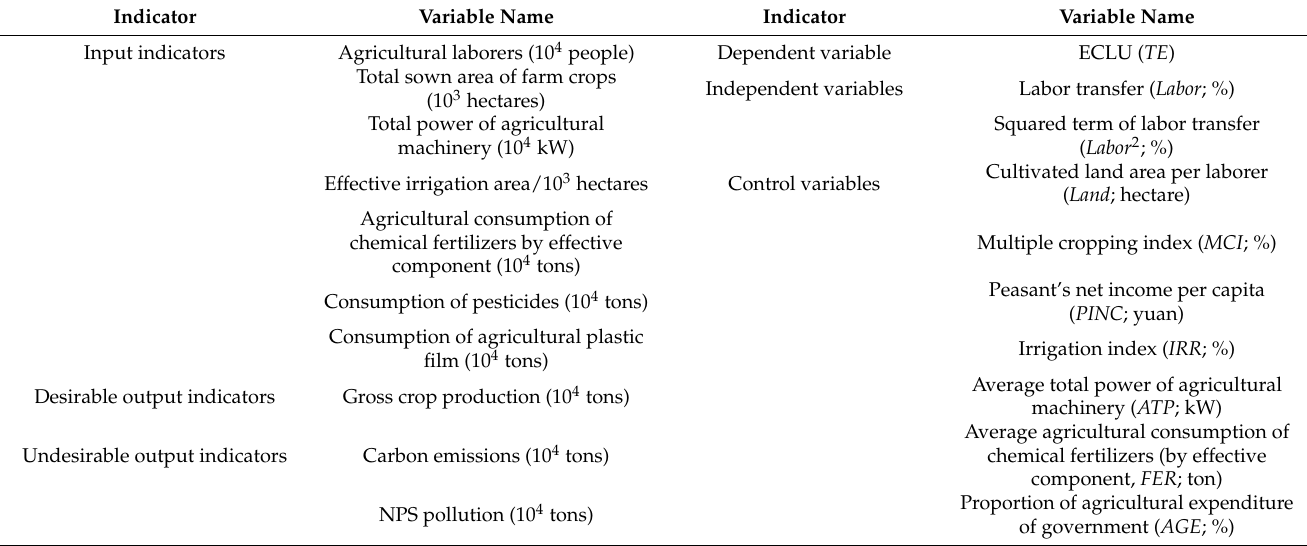
Table 1. A descriptive statistical analysis of